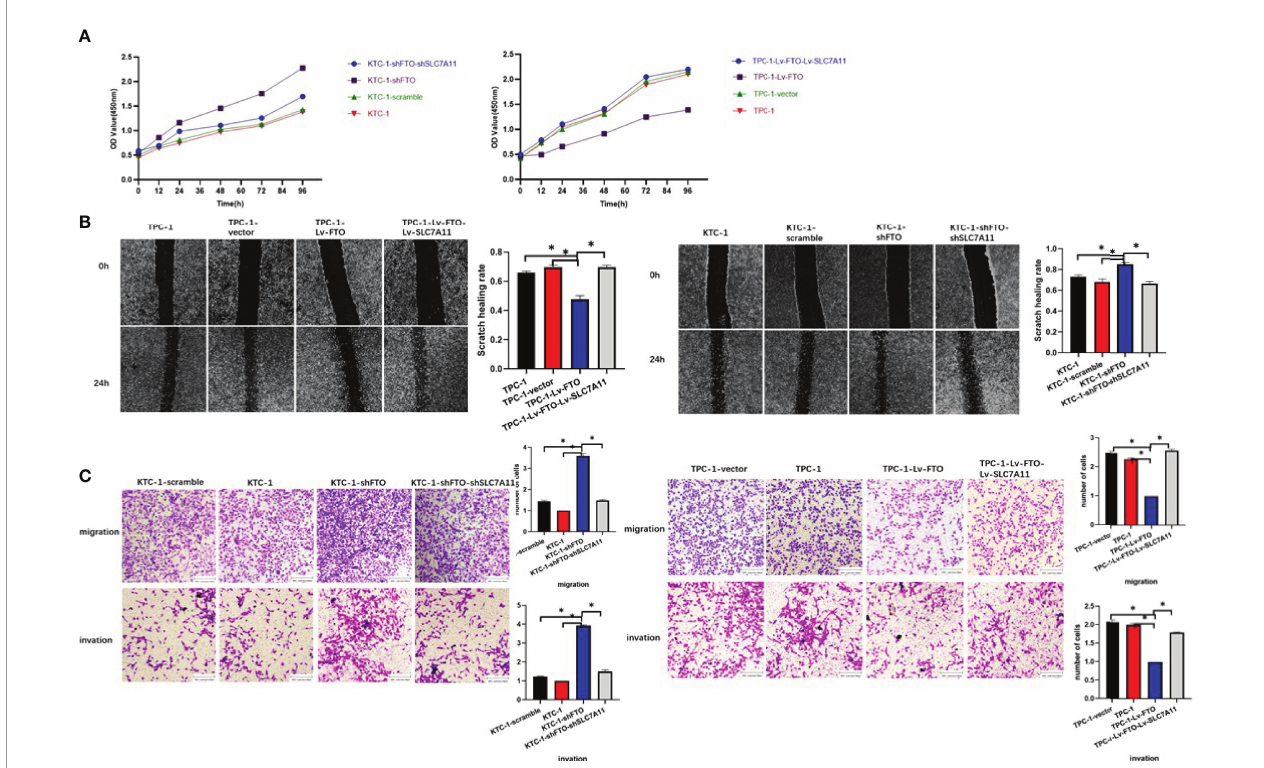
FIGURE 8 | The effects of fat mass and obesity-associated protein inhibition are reversed by the loss of SLC7A11. (A) CCK-8 assay. (B) Scratch test. (C) Transwell migration and invasion assay. *,